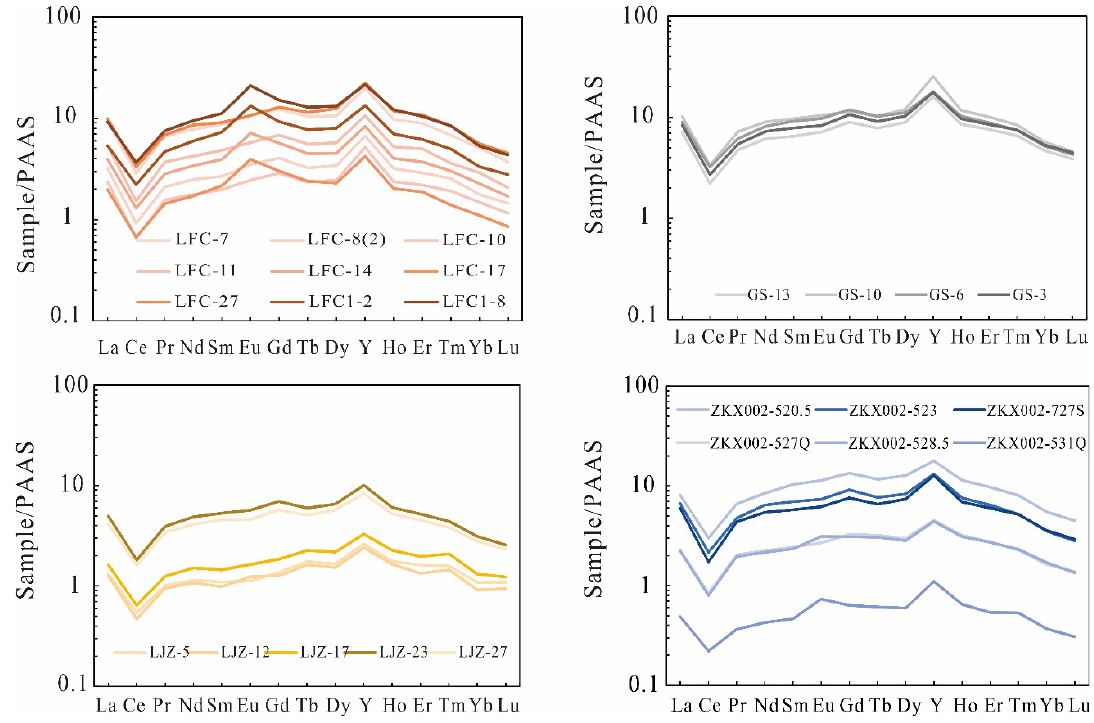
Figure 7. PAAS–normalized rare earth element distributions of phosphorites from four sections in Zhijin region.